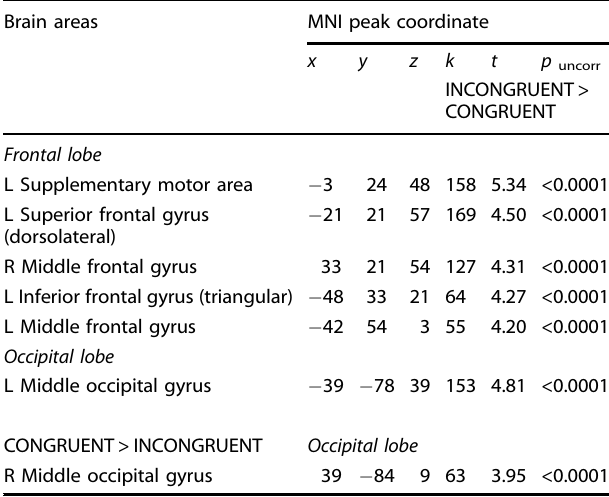
Table 3. Activation clusters for t -contrasts between congruent and incongruent statements in physics.